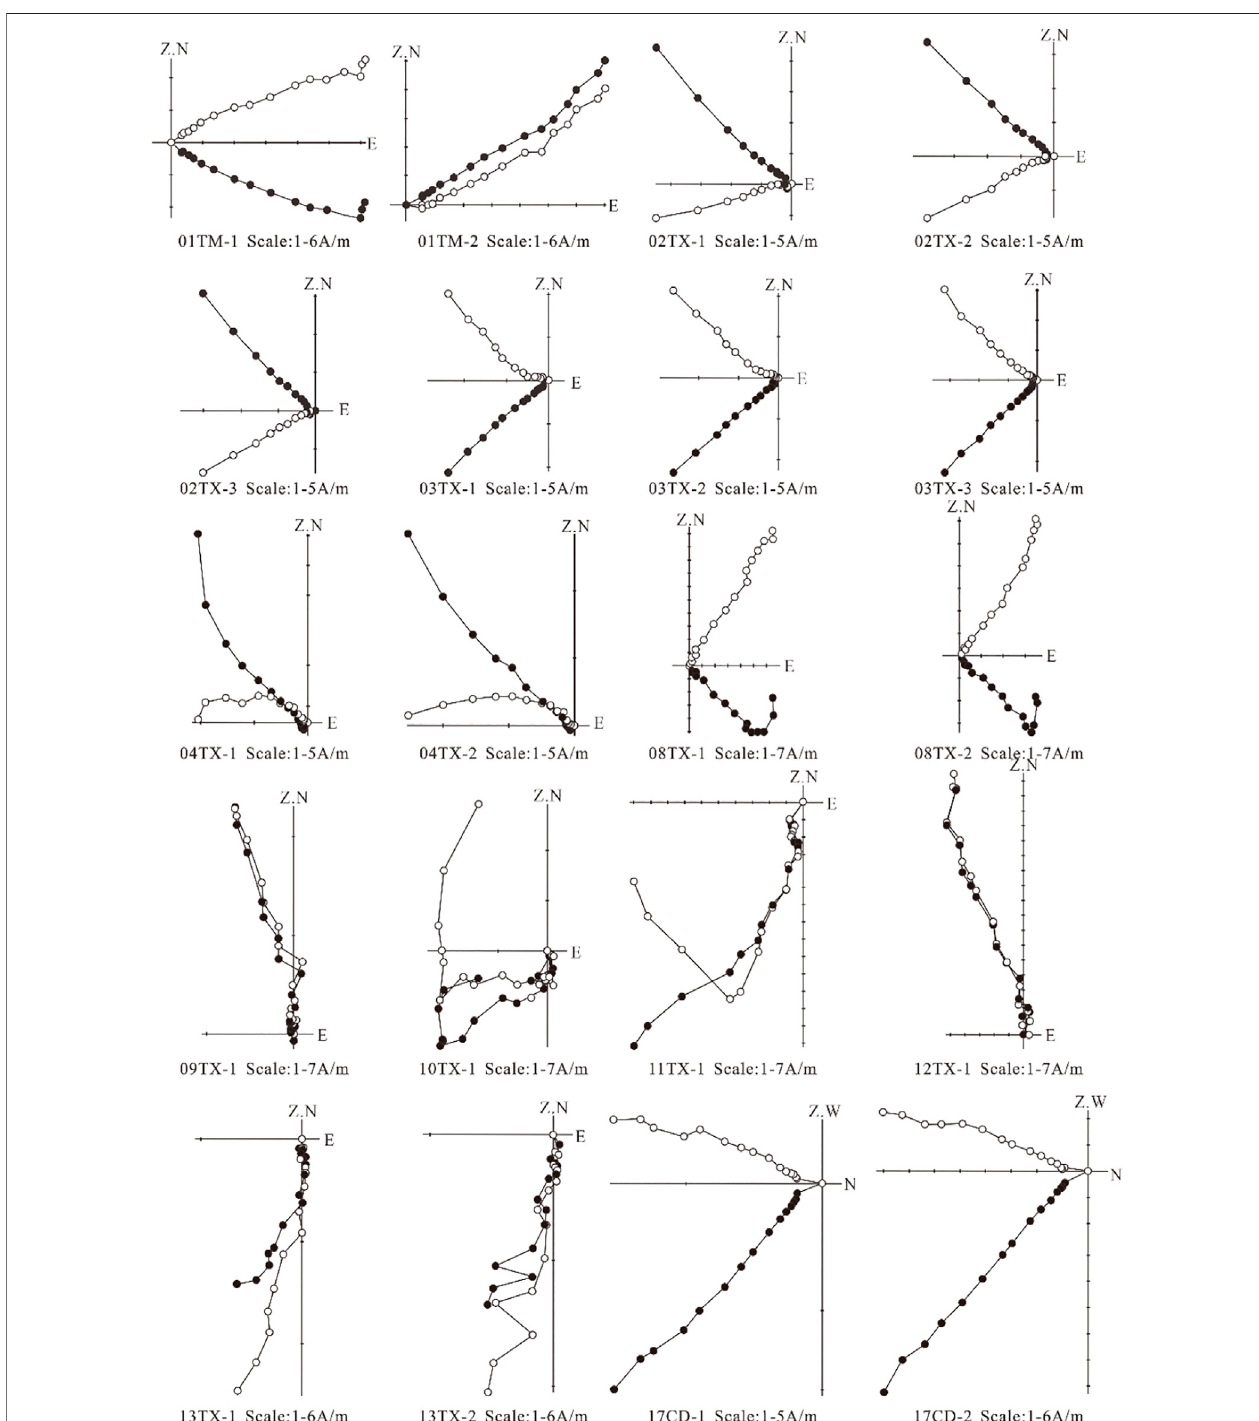
FIGURE 13 | Demagnetization curves of Niutitang shale samples in Cen ’ gong